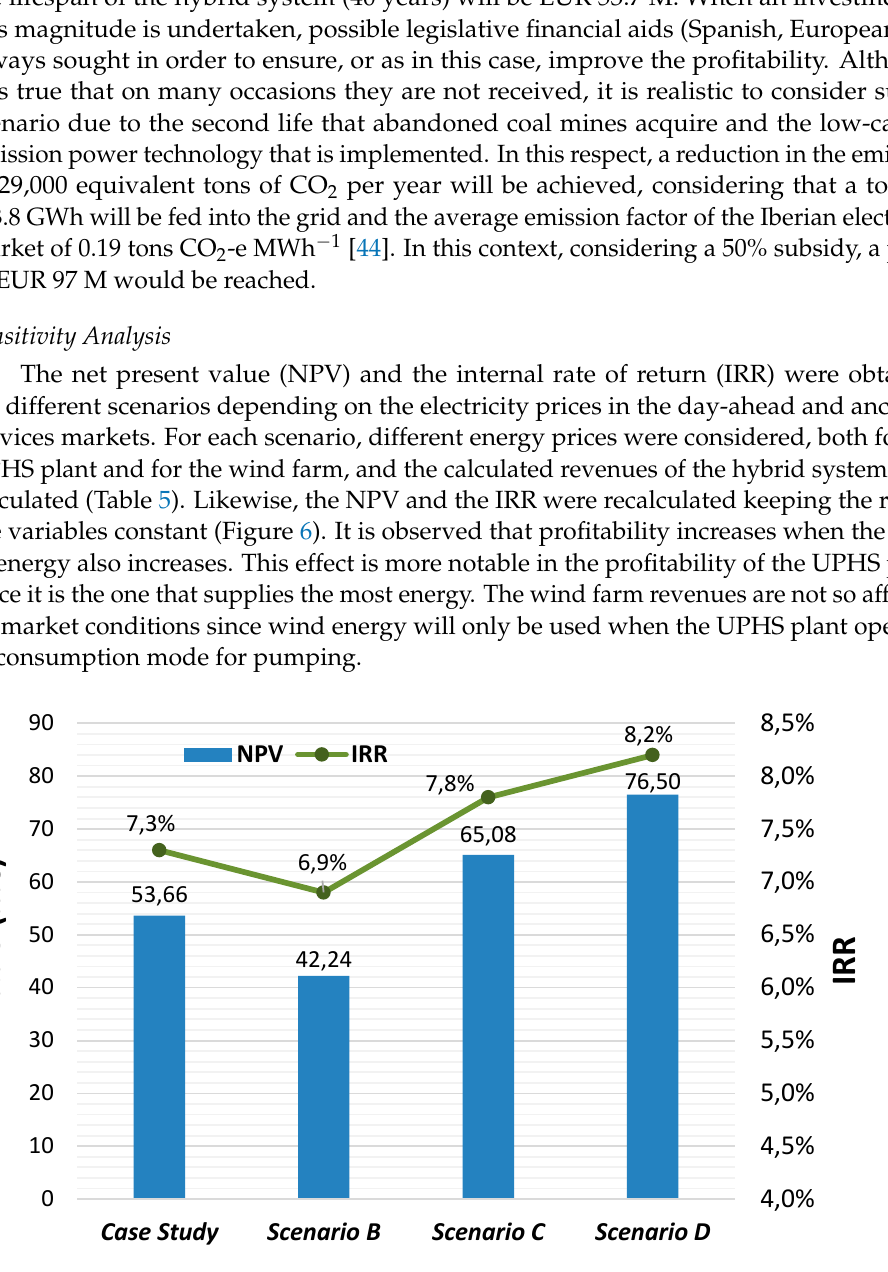
Table 5. Sensitivity analysis. Total annual energy sales revenues for different scenarios.